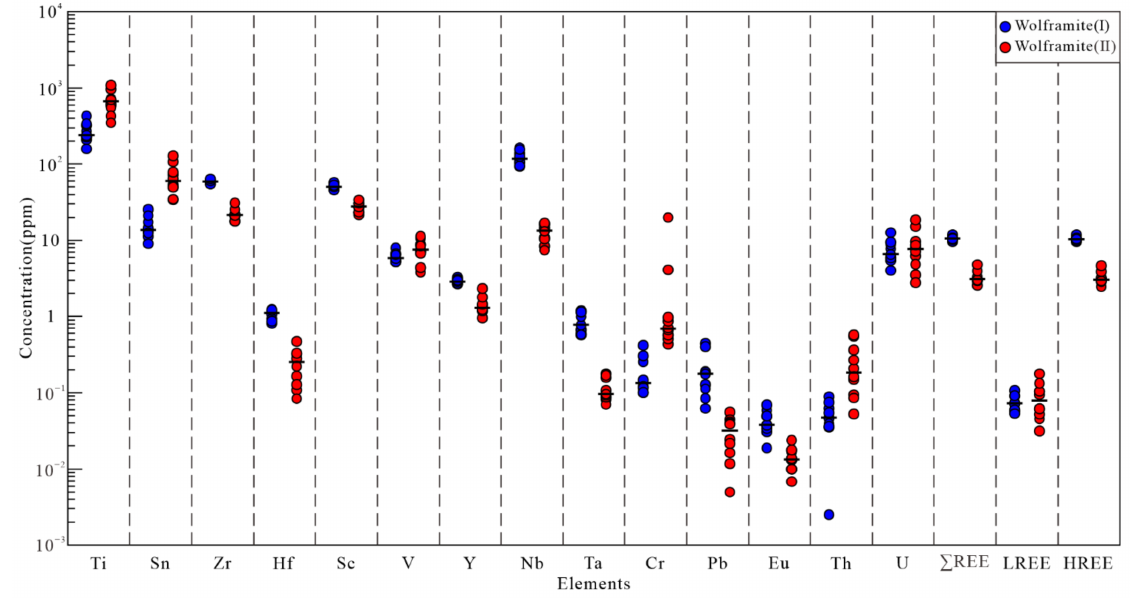
Figure 9. The concentrations of elements in wolframite from two mineralization stages of the Baishitouwa deposit. The bold horizontal line represents the median.